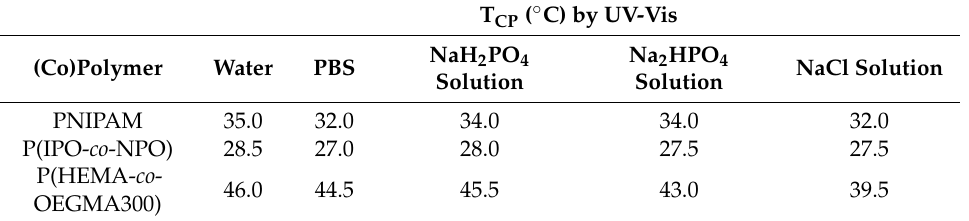
Table 1. Cloud point temperature (T CP ) of polymers in different solutions depicted from UV-vis traces. PNIPAM: poly( N -isopropylacrylamide); P(IPO- co -NPO): poly(2-isopropyl-2-oxazoline- co -2-n- propyl-2-oxazoline); P(HEMA- co -OEGMA 300 ): poly[2-hydroxyethyl methacrylate- co -oligo(ethylene glycol) methyl ether methacrylate].